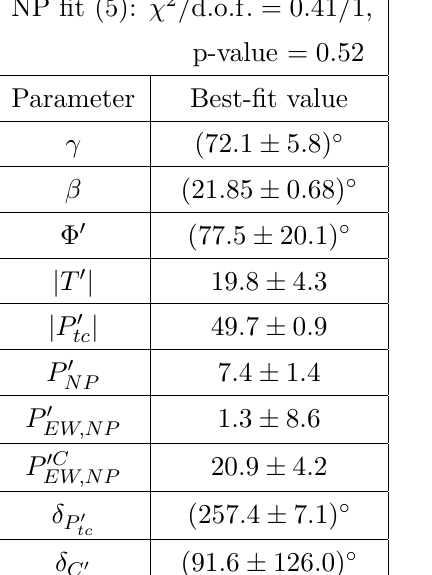
P 0 = P 0 C = 0. In model-building terms, this corresponds to the case where the Z 0 EW;NP EW;NP couples only to left-handed (cid:22) dd and (cid:22) uu , or where it couples vectorially to these quark